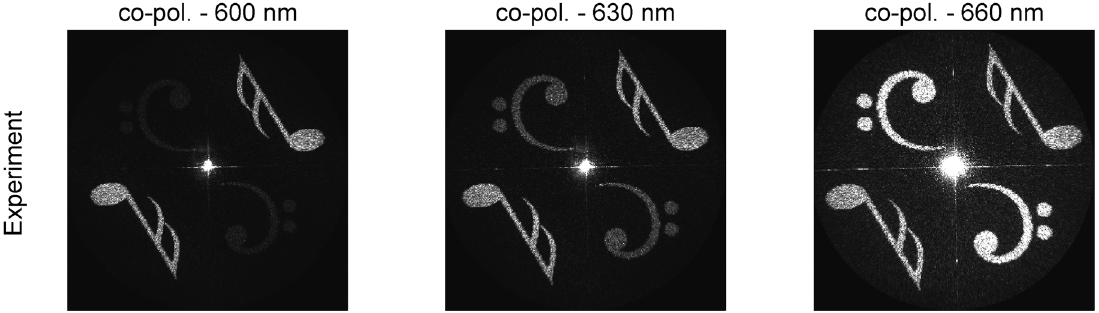
Figure 6: Measured holograms at wavelengths deviating from the design wavelengths. Through the different sperctaral behavior of the rectangularandsquarestructure,thehologrambehaviorchangesbychangingtheinputwavelengthotherthanthedesignwavelength,ascan be seen in the changing brightness of the partial However, the overall agreement of the measured holo- of the large contrast between the transmittance of grams with the target images illustrates how amplitude the rectangular and square shaped nanostructures at and phase holograms can be implemented in a single 690 nm, where the transmittance of the rectangular device to enlarge the information density of holograms, structures drops close to zero. Note, that also materials as well as switching images by changing the other than silicon can be used to obtain a similar effect.